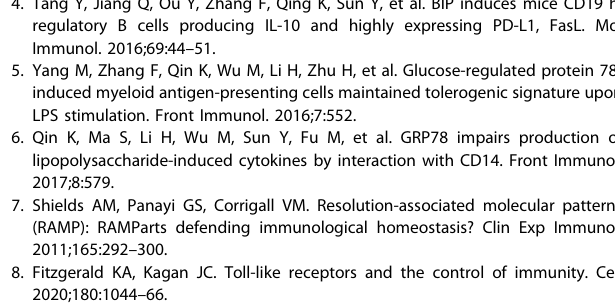
Fig. 8 sGRP78-promoted myeloid cells death is TLR4 dependent. BMDCs and BMDMs from WT and TLR4 KO mouse were treated with Grp78 for 24 h. Apoptosis were assayed by AnnexinV/7-AAD staining ( A , B ) and by Hoechst 33258 staining ( C ). Scale bar = 10 μ m. D – G Intracellular ROS ( D , E ) and lipid ROS ( F , G ). Data are mean ± SEM from three independent experiments. * P < 0.05, ** P < 0.01. H Schematic description for the role of sGRP78 (HSPA5) in inducing selective autophagy of monomeric TLR4 to regulate myeloid cell death.